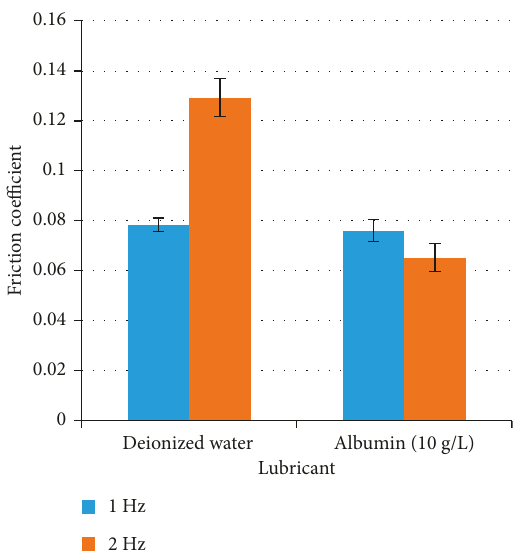
Figure 6: Effect of speed under 2 N load